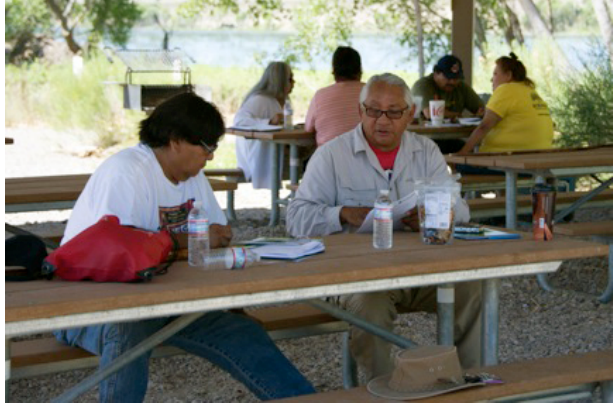
Fig. 5 . Interviews and focus groups conducted by Nuwuvi (Southern Paiute) Working Group members with Nuwuvi knowledge holders at the Pahranagat National Wildlife Refuge (part of the Desert National Wildlife Refuge Complex), Nevada. June 2013. Photo: Jeremy Spoon.